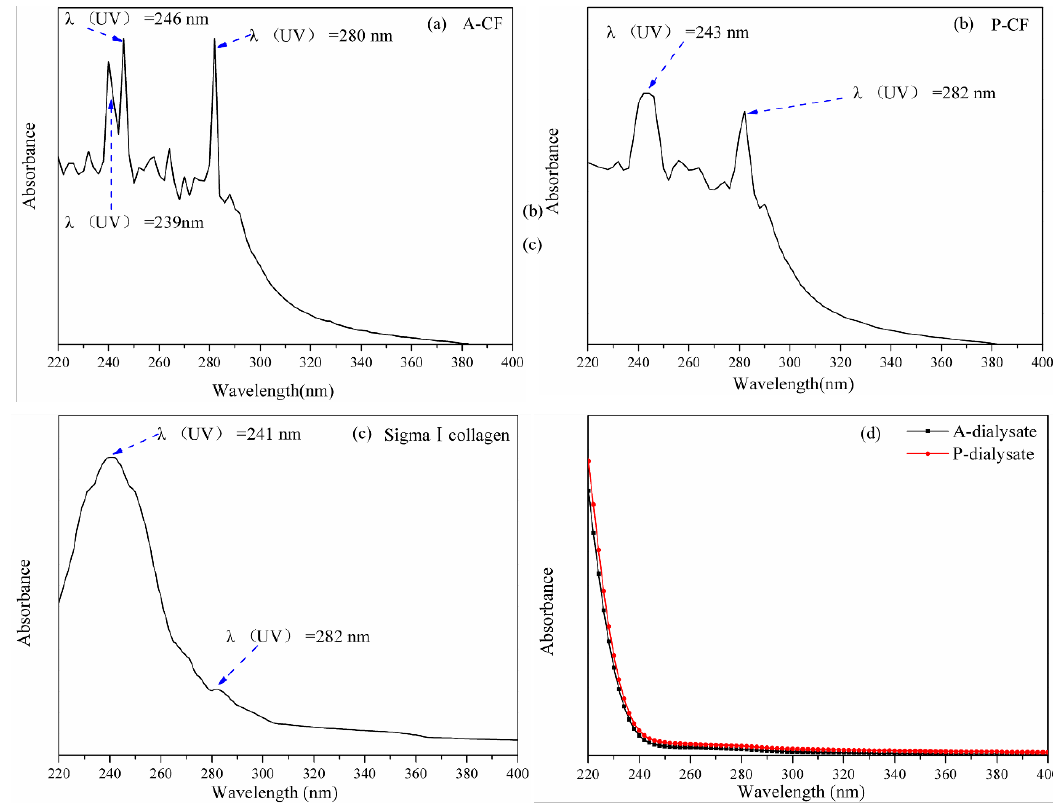
Figure 4. The UV–Vis spectra of A-CF ( a ), P-CF ( b ) and Sigma I collagen ( c ), and the dialysates ( d ) of A-CF and P-CF.